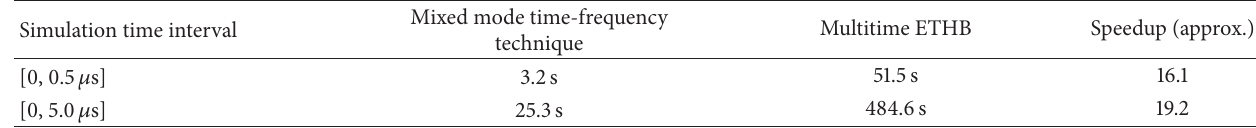
Table 2: Computation times—RF polar